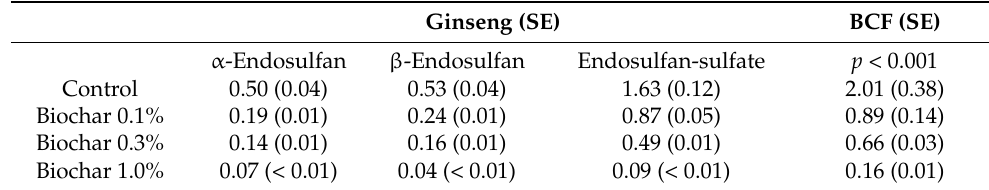
Figure 8. BCF (bioconcentration factor) of total endosulfan for two-year-old ginseng. Table 5. Concentration of endosulfan in ginseng with BCF (bioconcentration factor), SE–Standard Error. Ginseng